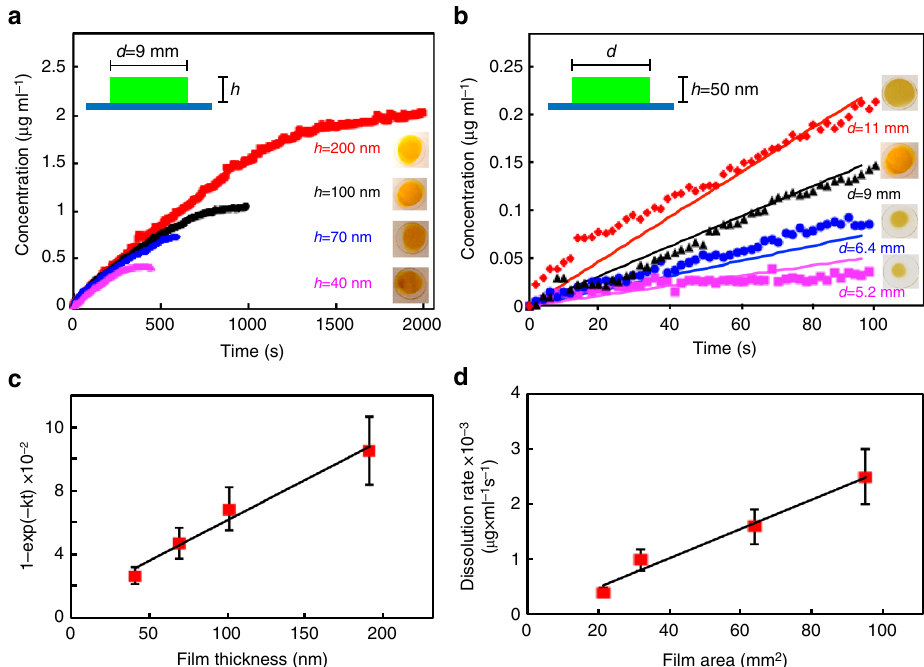
Fig. 6 Example of controlled dissolution in fl uorescein fi lms. Effect of varying fi lm thickness ( a ) or fi lm area ( b ) on dissolution pro fi les of fl uorescein fi lms in deionized water. c Dependence of (1 − e − kt ) (Eq. 2) on fi lm thickness. Numbers were extracted from data in plot a . d Films dissolution rate vs. fi lm area. The rates were extracted from data in plot b . Error bars correspond to measurement of at least three samples ± standard